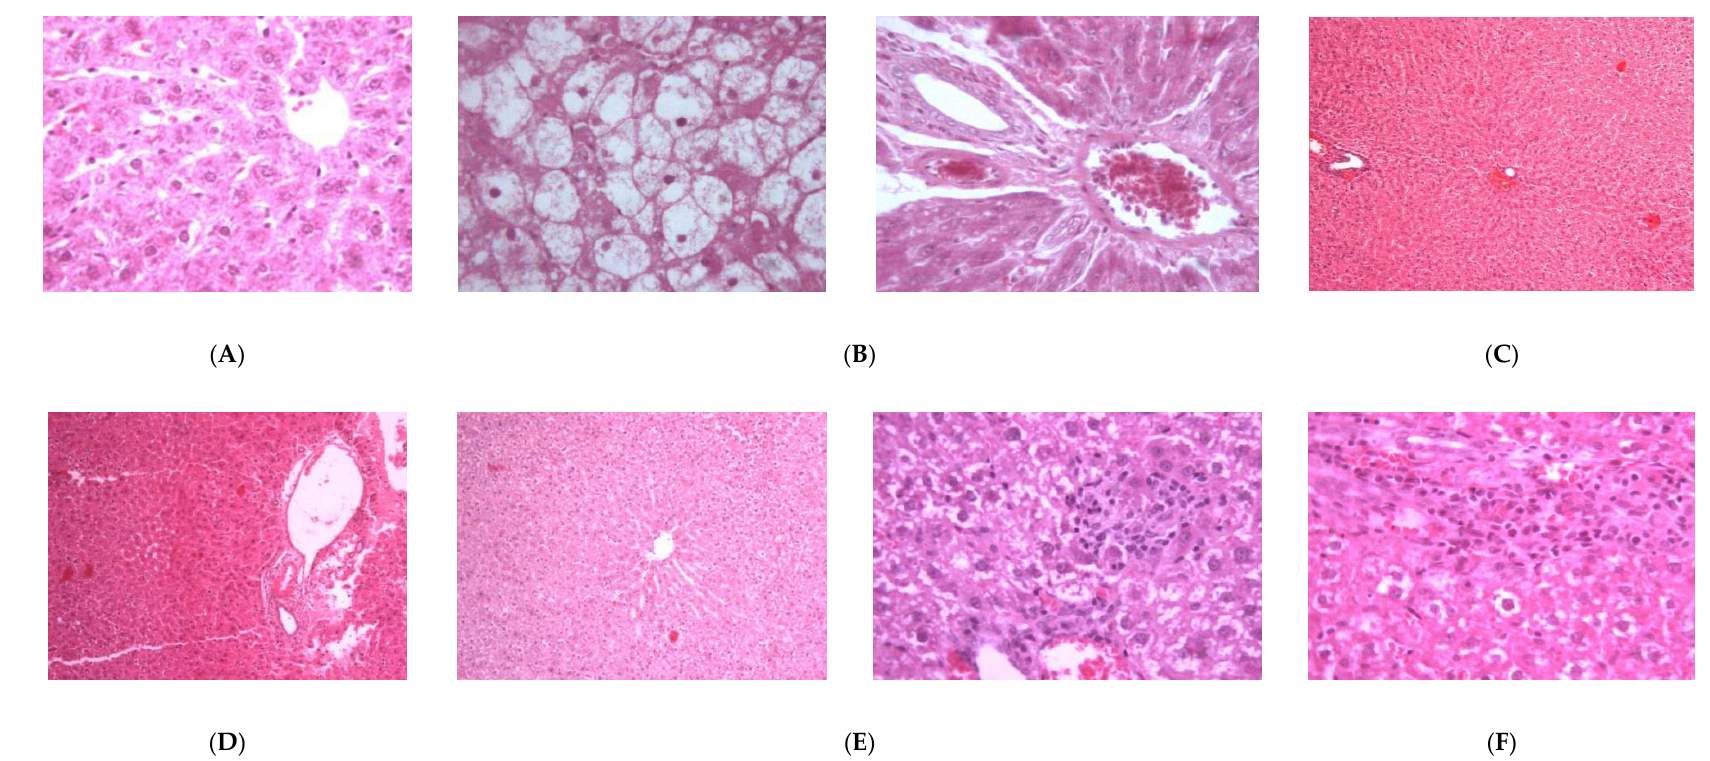
Figure 5. Light microscope pictures of liver tissues: ( A ) Liver cells of normal control group showing central vein, normal sinusoids and cells. ( B ) Liver cells of Pa-treated group showing hydropic swelling, rosette formation, portal dilated congested vessels, focal necrosis, lymphocytic infiltrate and lymphocytic exudate. ( C ) Liver cells of Pa- and Sil-treated group showing mostly normal cells with mild congestion in the central venules. ( D ) Liver cells of group treated with 3 showing almost normal lobules and portal tract with the absence of degeneration and vein congestion. ( E ) Liver cells of group treated with 4 showing mild focal necrosis and portal tract congestion. ( F ) Liver cells of group treated with 6 showing moderate to high degree of degeneration, portal congestion and inflammatory cell infiltration.